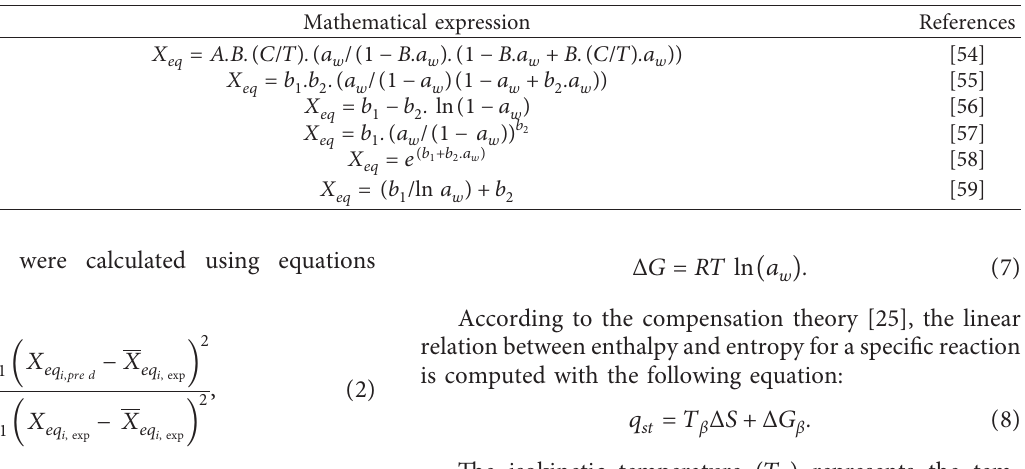
Table 1: Moisture sorption isotherm models used to analyze data for